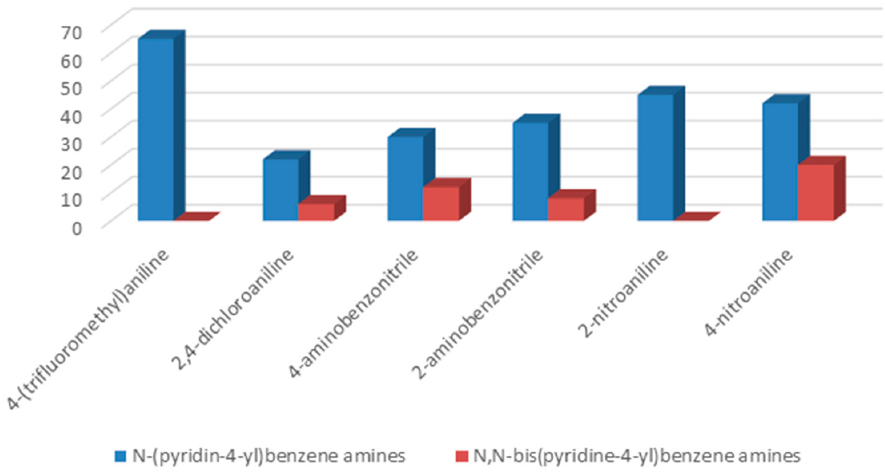
Figure 2. Comparison of yields for different aromatic amines in C-N coupling reaction with 4-chloropyridine in the presence of KHCO 3 as a base.